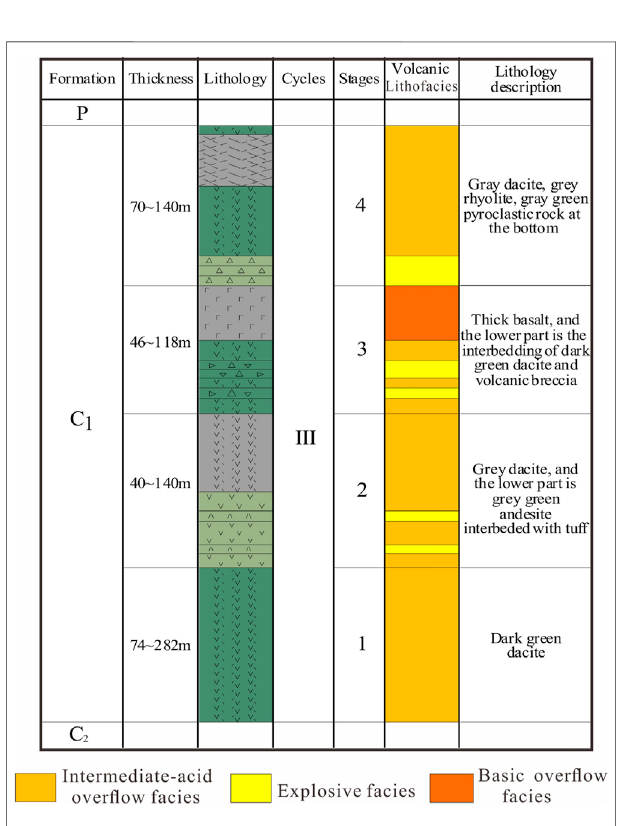
FIGURE 2 | Lithologic histogram of the upper Carboniferous in the Shixi area.